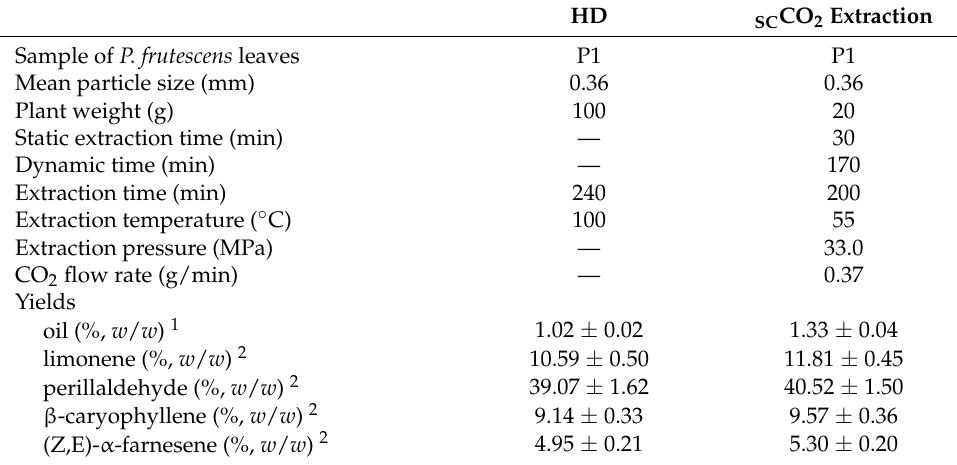
Table 1. Comparison of the extraction conditions and yields obtained by hydrodistillation (HD) and supercritical carbon dioxide ( SC CO 2 )